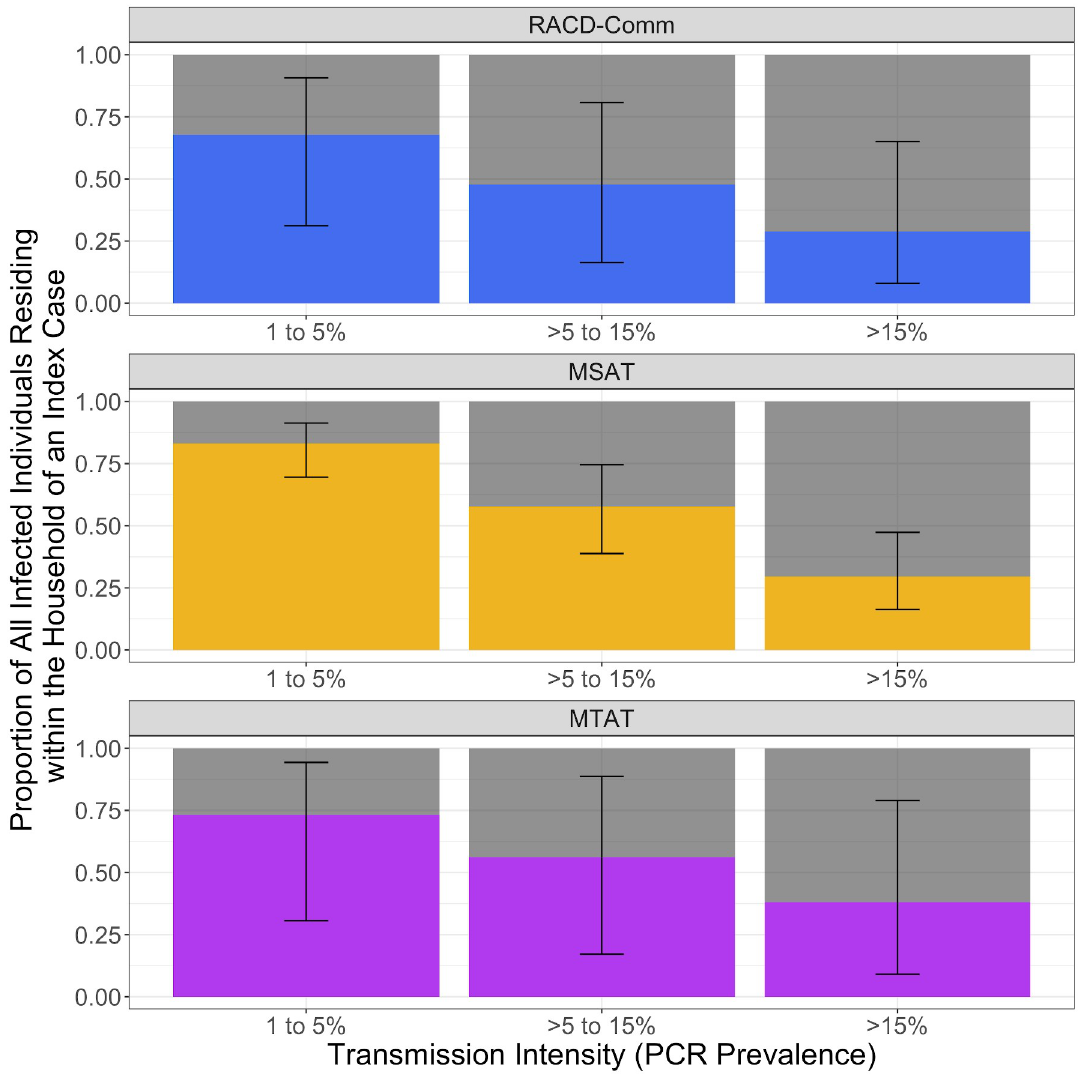
Fig 4. Bar graphs representing the results from the simulated data showing the proportion of all infections in a community that would likely be detected if RACD, MSAT, or MTAT strategies were employed. Each panel shows the results for a different reactive strategy with bars ordered by transmission strata according to the PCR prevalence in a community of 1,000 people (e.g., 1% to 5%, > 5% to 15%, and > 15%). The height of each bar represents the total number of infections within a community, with the colour representing the proportion of infections that would be targeted according to each strategy (black bars corresponding to the 95% CI) with the grey section showing the infections that would be missed. MSAT, Mass Screen and Treat; MTAT, Mass Test and Treat; RACD, Reactive Case